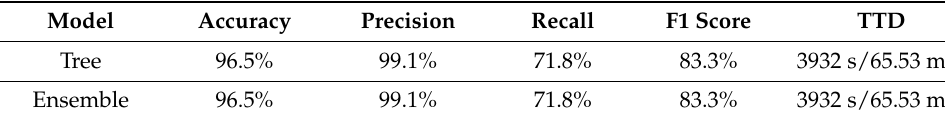
Figure 13. Experiment 1 approach. Table 3. Experiment 1 results.